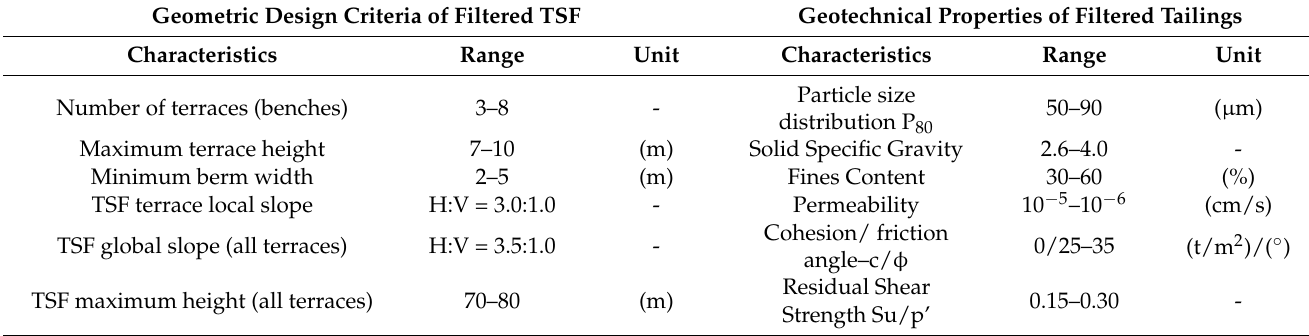
Table 1. Geometric Design Criteria and Geotechnical Properties of Dry Stack TSF